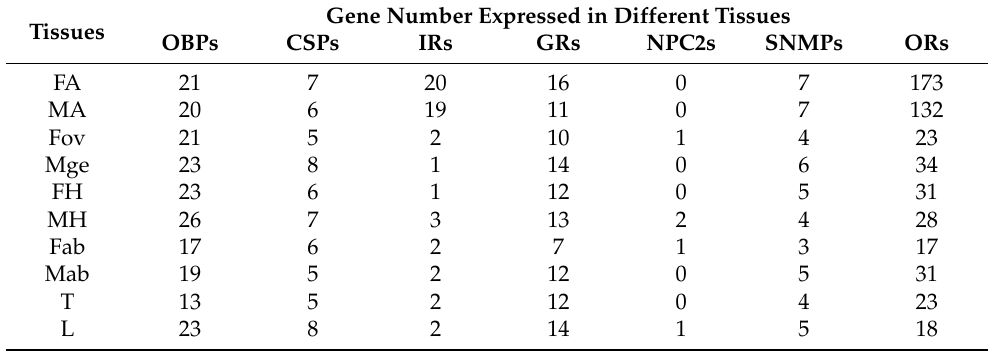
Table 3. Summary of chemosensory genes expressed in various tissues of B. dioryctriae (FPKM > 1). Tissues